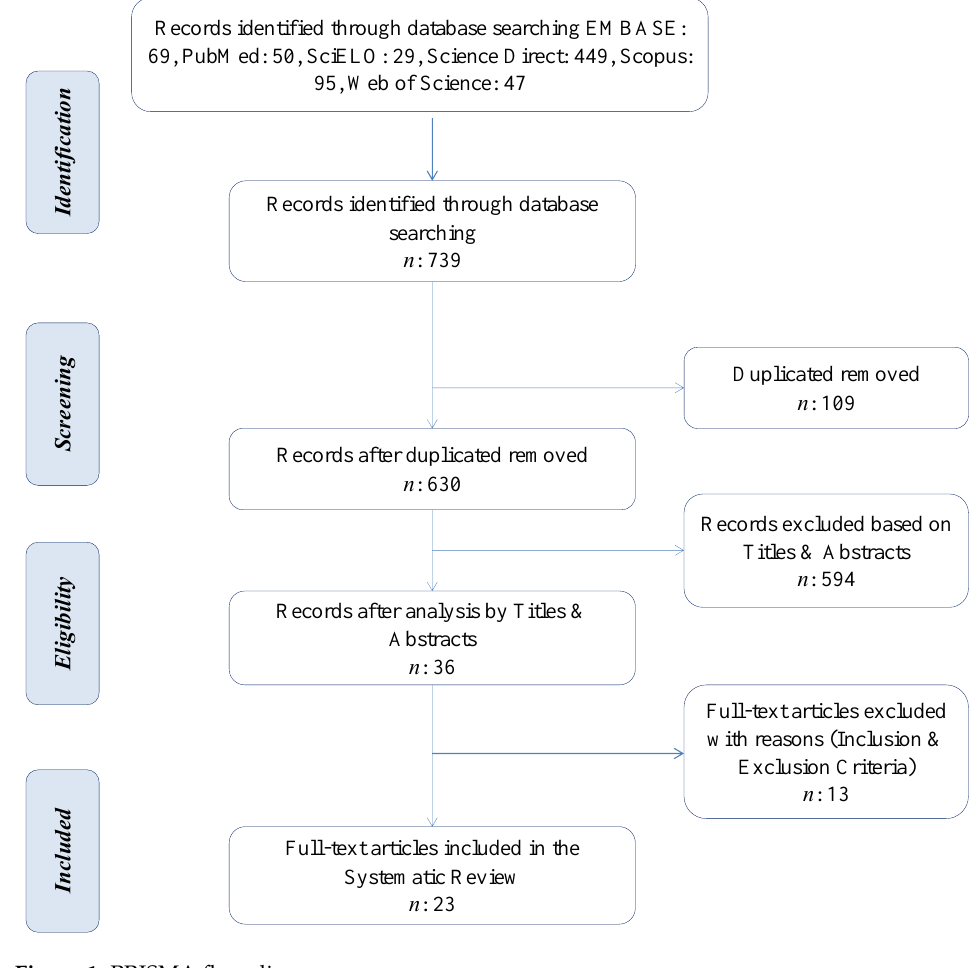
Figure 1. PRISMA flow diagram.